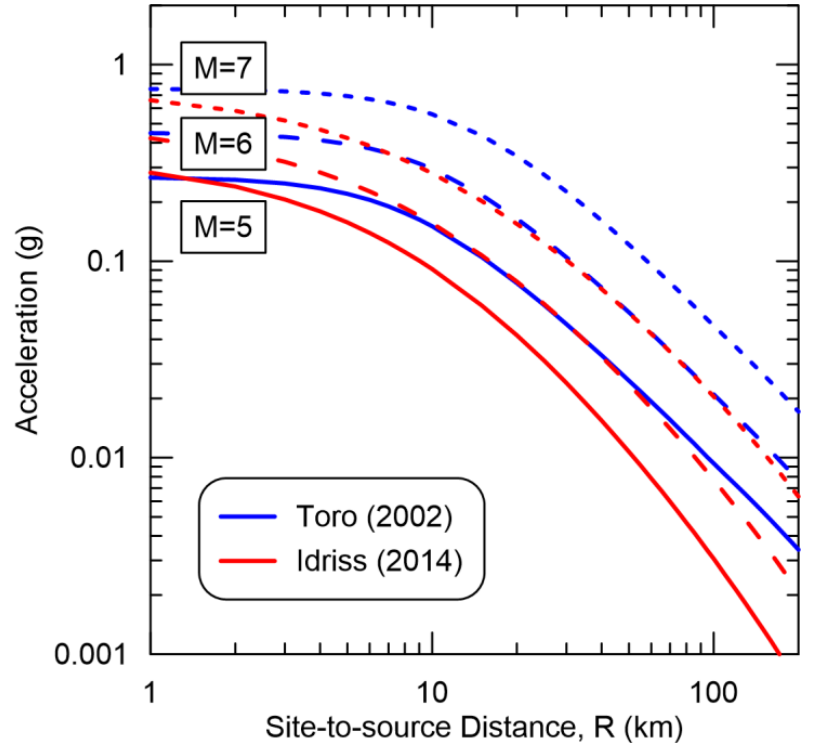
Figure 1. Results from considered ground motion prediction equations in terms of PGA for M w = 5, 6, and 7 [29,30].